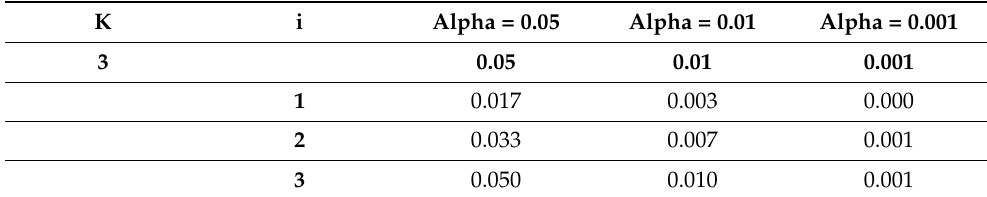
Table 2. Benjamini–Hochberg correction for multiple comparisons: comparison of microRNA gene expression between various groups of pregnancies (AGA pregnancies vs. FGR pregnancies vs. SGA